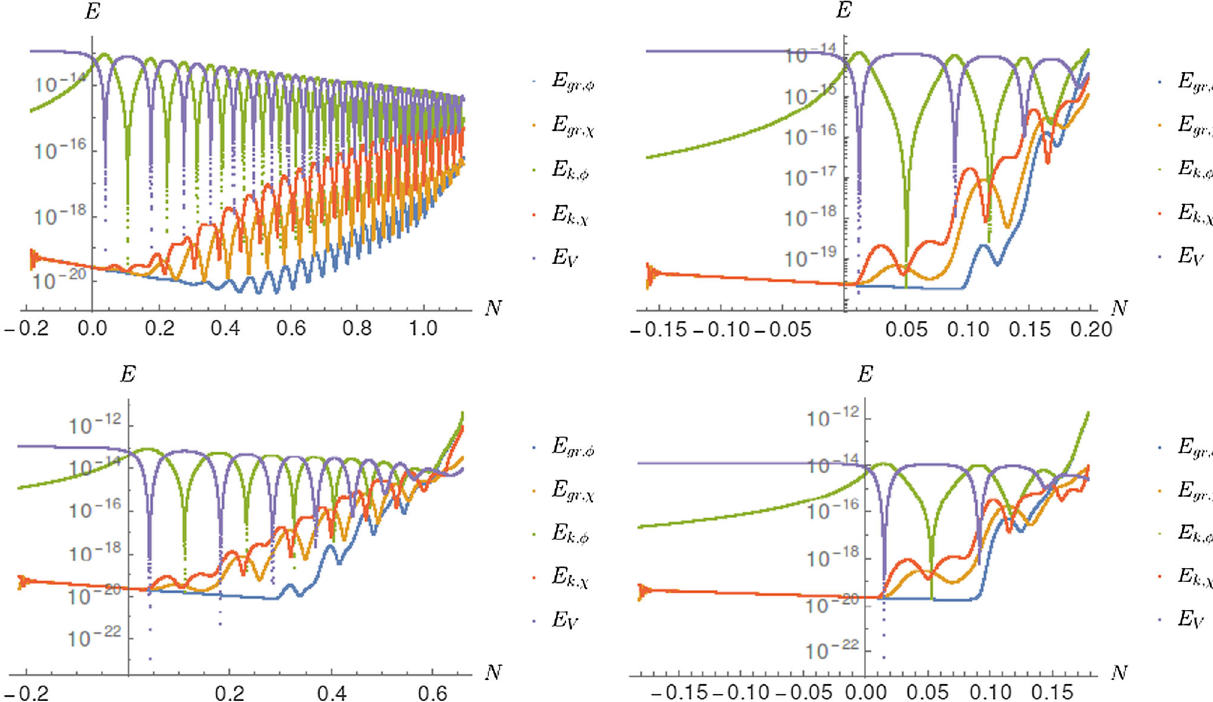
Fig. 11 The evolution of the components of the energy density for n = 1 , α = 10 − 3 (upper left), n = 1 , α = 10 − 4 (upper right), n = 1 . 5 , α = 10 − 3 (lower left), n = 1 . 5 , α = 10 − 4 (lower right). N is the number of e-folds after the end of